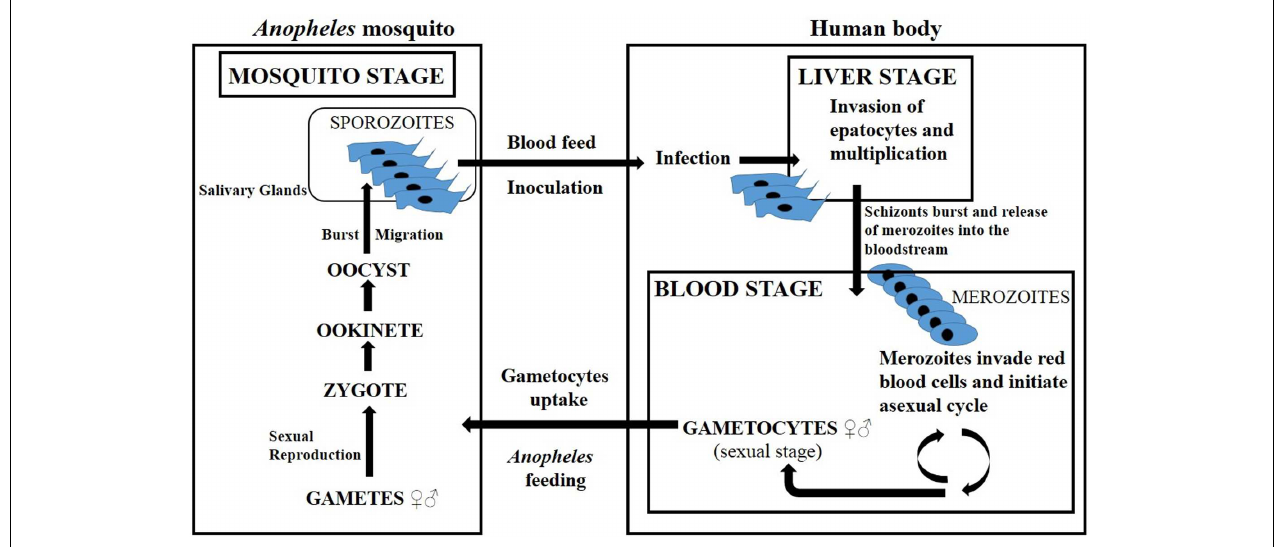
FIGURE 1 | Lifecycle of Plasmodium falciparum (adapted from Cox, 2010). The cycle starts when a mosquito inoculates motile Plasmodium sporozoites, which then move from the dermis to the liver, through the bloodstream. The sporozoites invade the hepatocytes and proliferate. One week after, the liver schizonts burst, releasing a great number of merozoites into the bloodstream. These invade the erythrocytes and start the asexual cycle, with some parasites developing into male and others into female gametocytes (precursors of gametes). After feeding, the Anopheles mosquito ingests the gametocytes from the blood. Once inside their vector, they can reproduce sexually, originating in an ookinete and then an oocyst. The oocyst bursts, releasing sporozoites, which migrate to the salivary glands and the cycle is